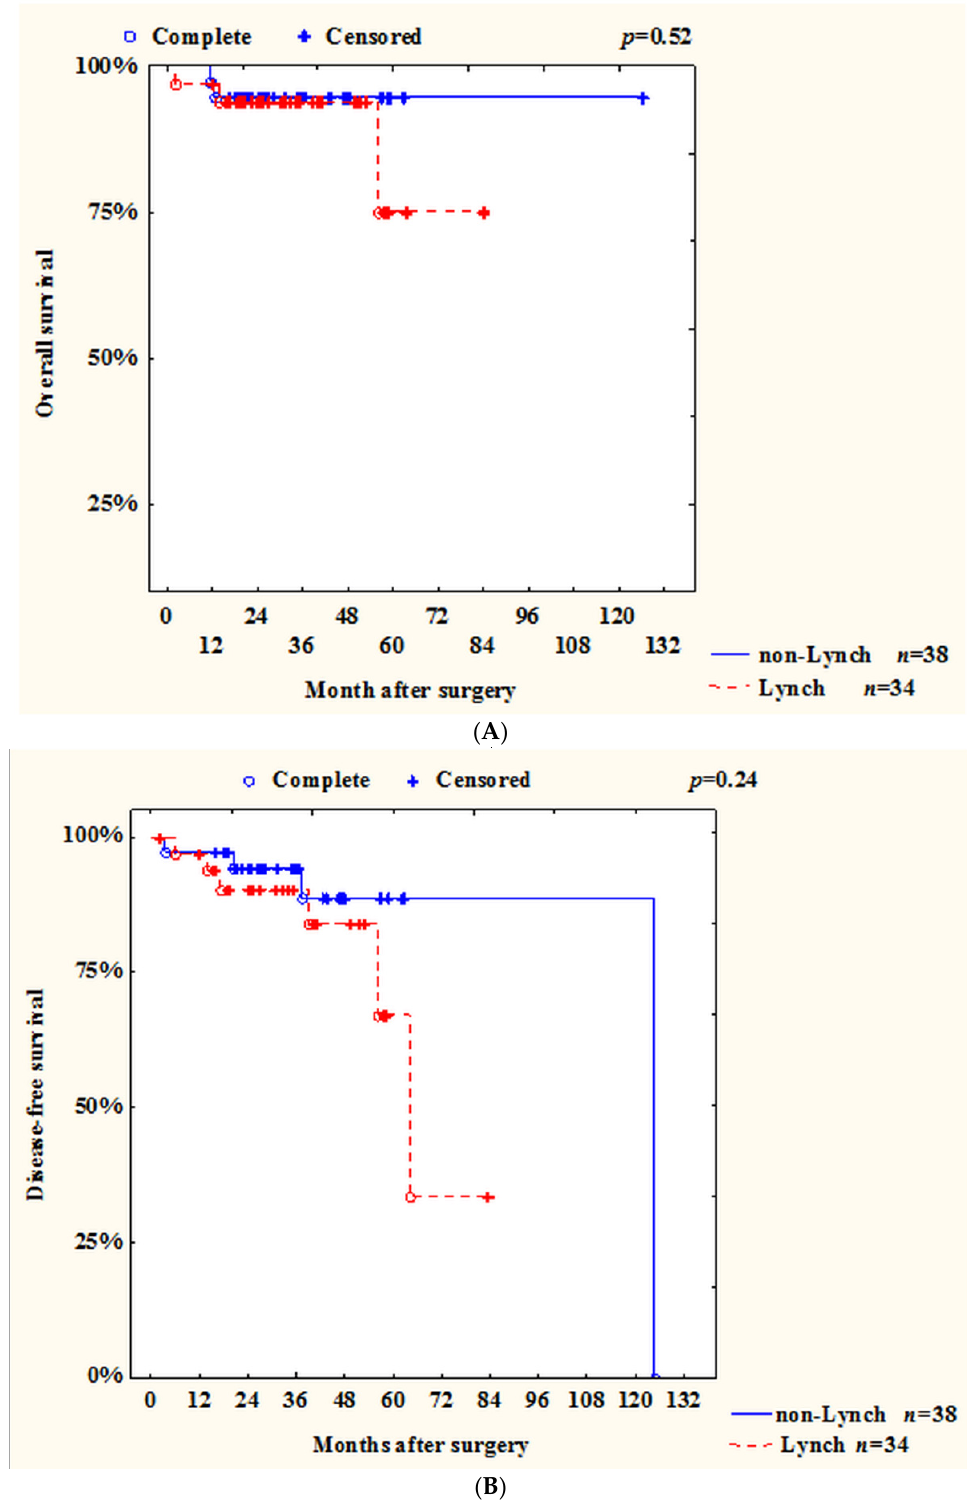
Figure 3. Rates of overall and disease-free survival in patients with Lynch syndrome and patients with MSI status of sporadic tumor: ( A ) overall survival; ( B ) disease-free survival. 2.5. Analysis of Risk Factors of Patients with MSI Status